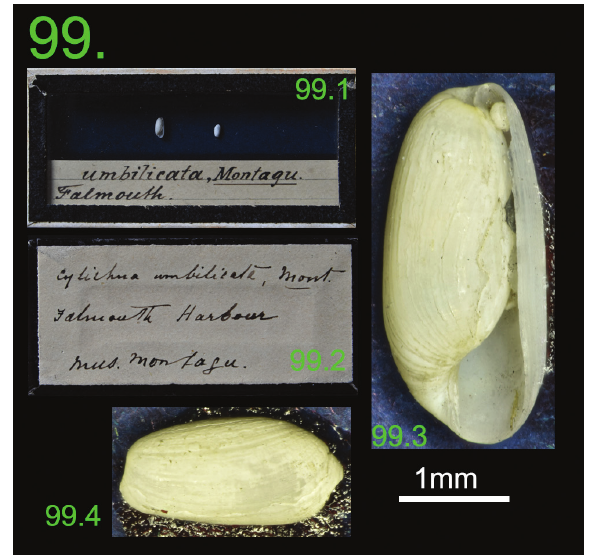
Figure 99. Bulla umbilicata Montagu, 1803 [ Retusa umbilica - ta (Montagu, 1803)] 99.1/2 Top and bottom of box indicating type status but no original labels 99.3 Apertural view of larger syntype NHMUK1998038/1. 99.4 Abapertural view of smaller syntype